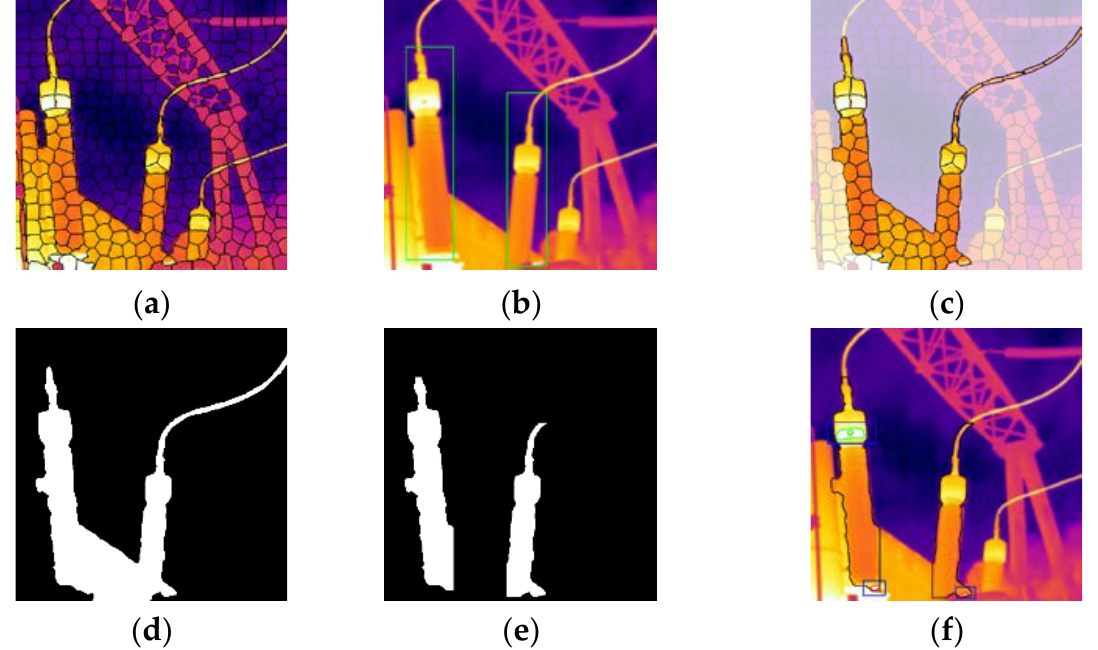
Figure 10. The results of each step in the process of diagnosis by Li’s method ( a ) Super pixel segmentation ( b ) Image recognition ( c ) Super pixel binning ( d ) Image segmentation ( e ) Area to be inspected ( f ) Diagnosis result.